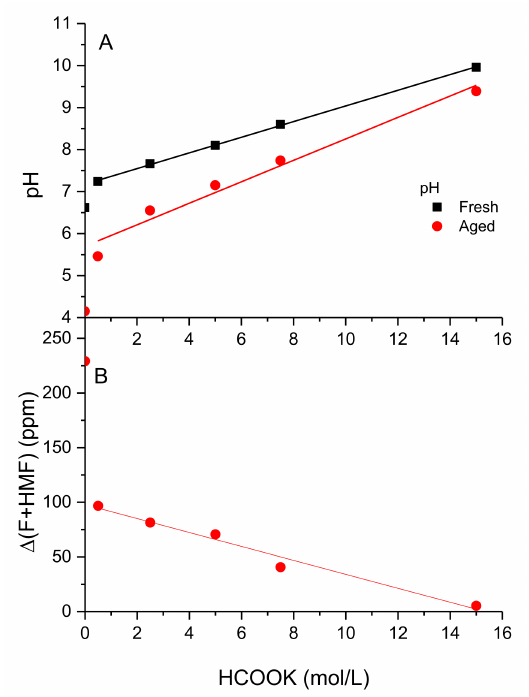
Figure 6. Degradation measured as: ( A ) Evolution of pH. ( B ) Furfural and hydroxymethyl/ furfural